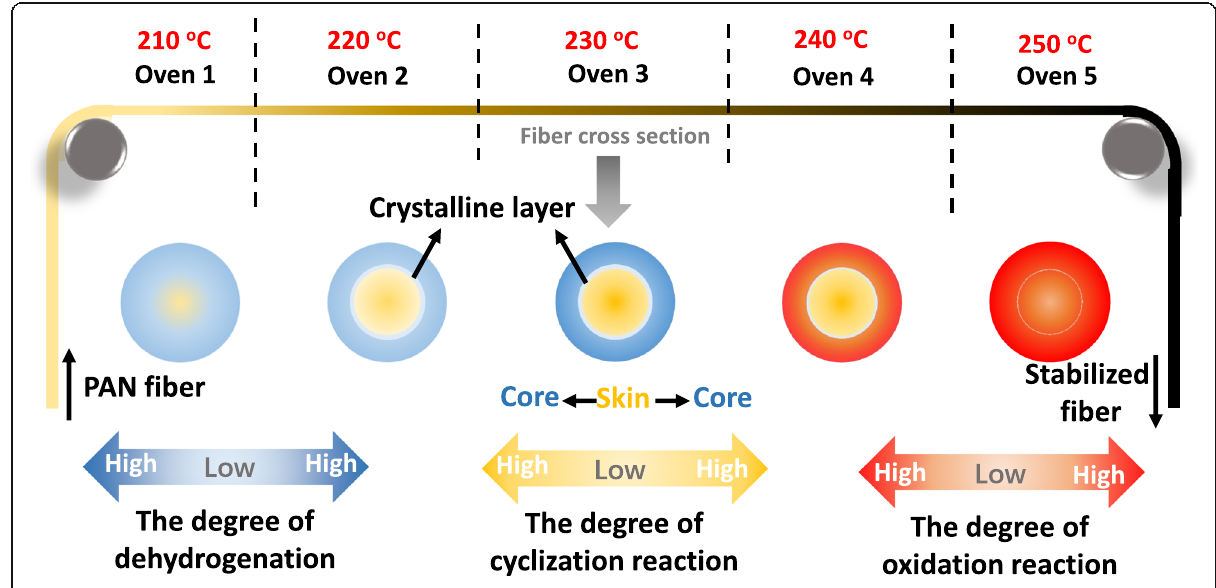
Fig. 6 Formation mechanism of the skin-core structure of stabilized PAN